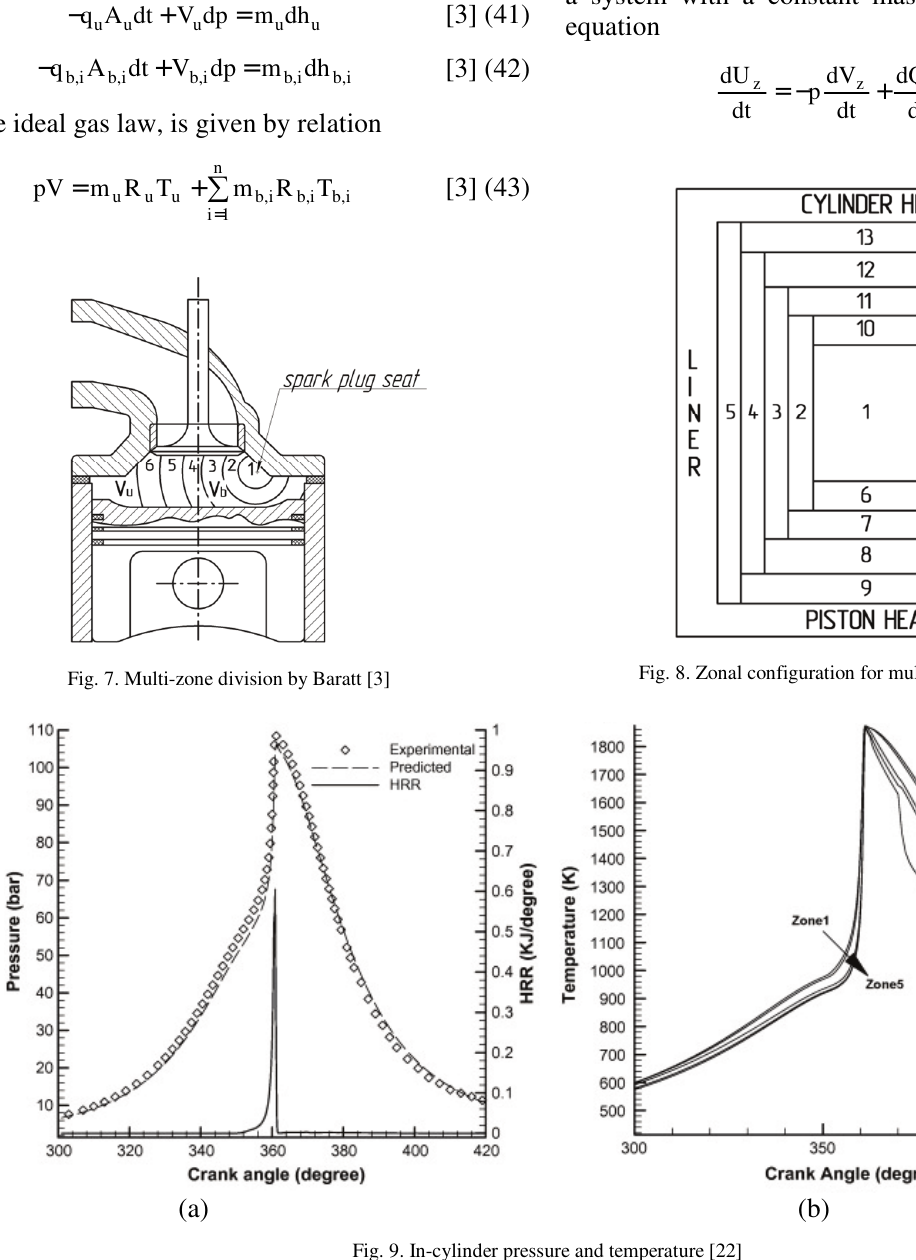
Fig. 9. In-cylinder pressure and temperature